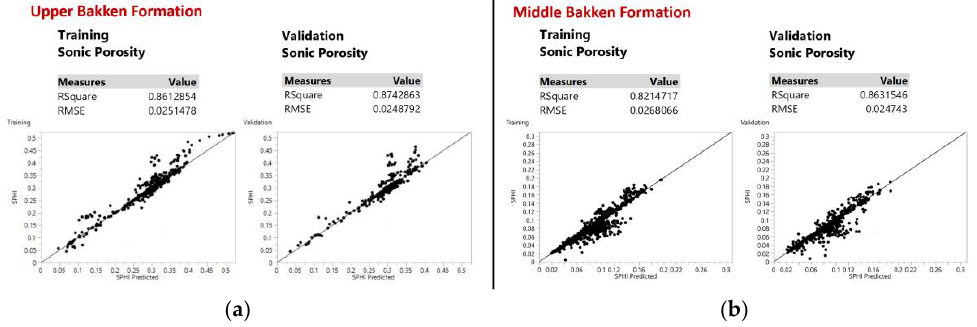
Figure 10. Prediction of sonic porosity using ANN with its training and validation set for ( a ) the Upper Bakken Formation ( b ) Middle Bakken Formation.